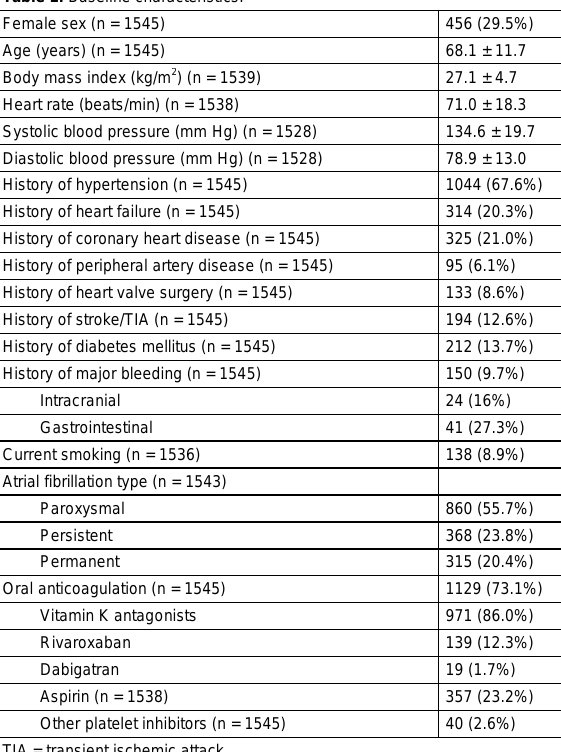
Table 1: Baseline